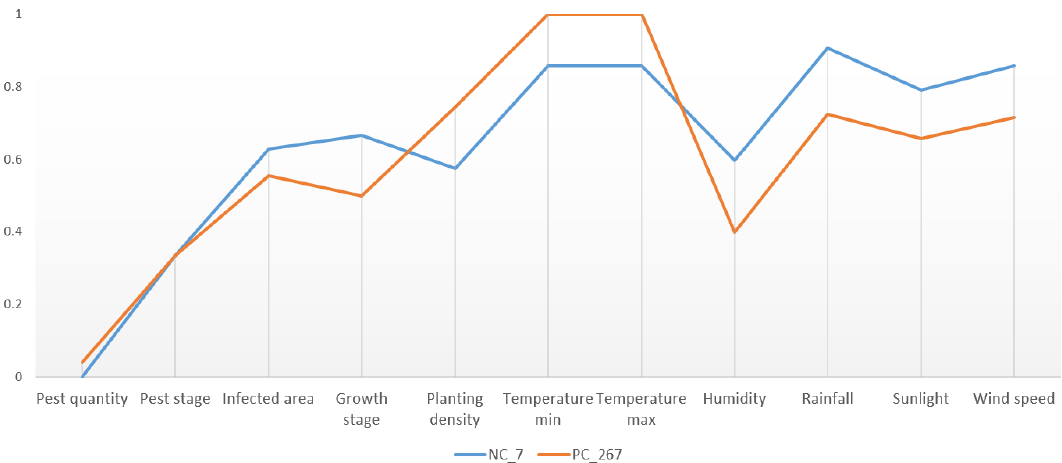
Figure 10. Data visualization of the new case 7 and the retrieved most similar case (past case 267) after normalization.